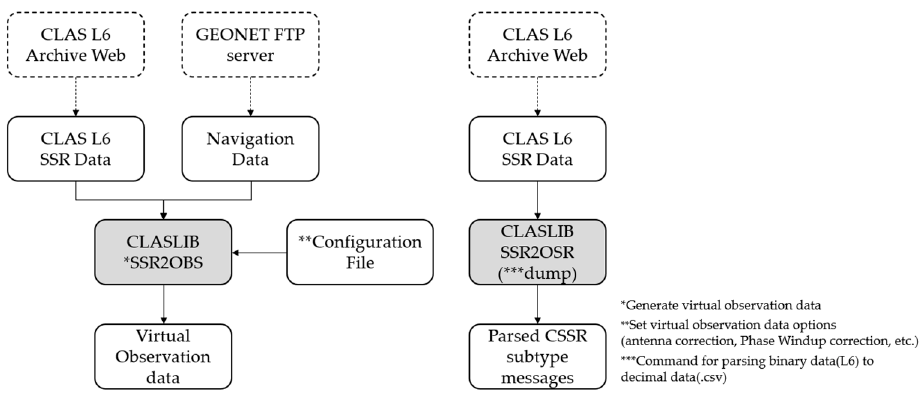
Figure 1. Data extraction of CLAS L6 broadcast messages using CLASLIB.